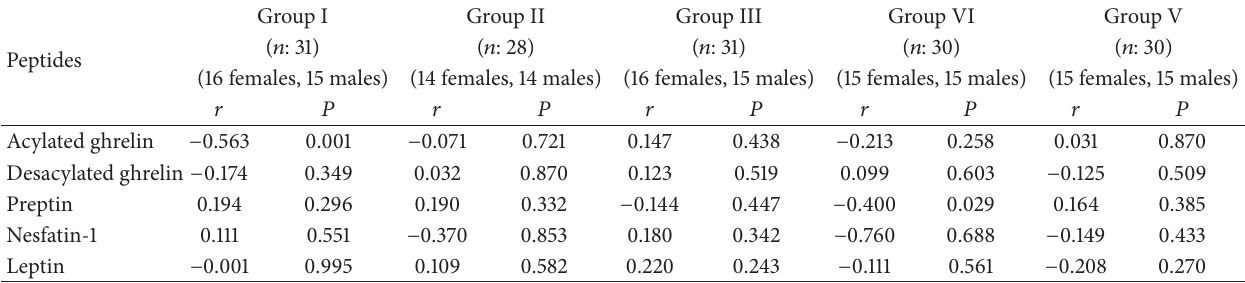
Table 2: Correlation between acylated ghrelin, desacylated ghrelin, preptin, nesfatin-1, and leptin levels and BMI in study groups.